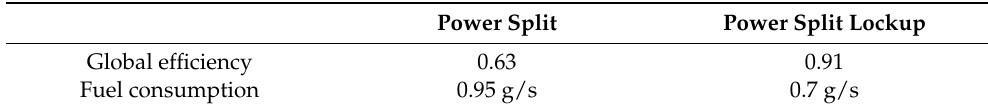
Table 5. Comparison between power split and power split with lockup clutch through the standard UNI-EN 15429-2 cycle.